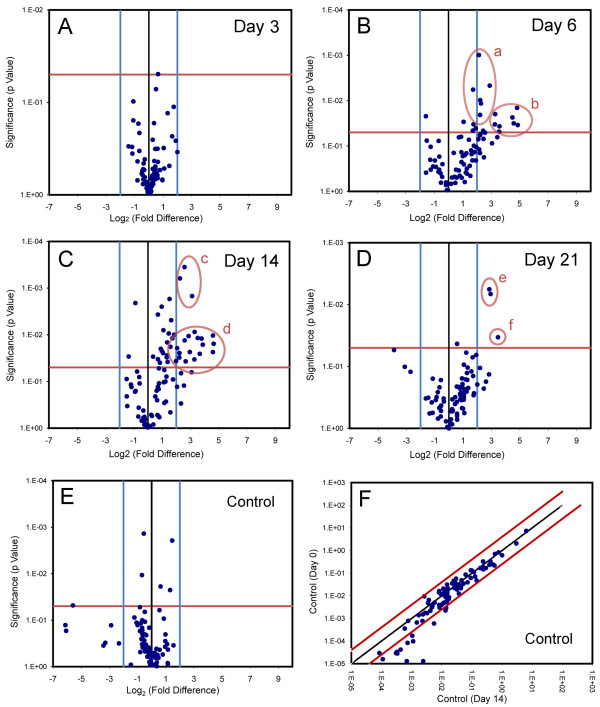
Expression of angiogenesis-related genes in CD31+ cells after pneumonectomy. A-D) Gene expression in mice 3, 6, 14 and 21 days after pneumonectomy was compared to age-matched controls without surgery. The log2 fold-change in gene expression was plotted against the p-value (t-test) to produce a "volcano plot." The vertical threshold reflected the relative statistical significance (red horizontal line, -log10, p < 0.05); the horizontal threshold reflected the relative fold-change in gene expression (blue vertical line, 4-fold). The significantly up-regulated expression of specific genes (red elipses): a) Tnfaip2, Plg, Anpep, Pgf, Vegfb and Thbs2; b) Csf3, Col4a3, Sphk1, Ereg, Vegfa, Lect1, Col18a1 and Il6; c) Ereg, Ephb4 and Vegfa; d) Tbx1, Cxcl5, Col4a3, Col18a1, F2, Vegfc, Sphk1, Ccl11, S1pr1, F2, Il6, Lect1, Flt1 and Csf3. e) Sphk1 and Vegfa; f) Csf3. Each data point reflects triplicate or quadruplicate arrays of 9 to 21 mice (Day 0, N = 15 mice; Day 3, N = 9 mice; Day 6 = 9 mice; Day 14, N = 9 mice; Day 21, N = 21 mice). E) Indicating a limited impact of the thoracotomy alone, the volcano plot comparison of sham thoracotomy and no surgery control demonstrated no significant change in gene expression on Day 14 after pneumonectomy. F) Scattergram indicating the stability of the control cell population (CD11b- CD31- ) used for gene expression analysis. Angiogenesis gene expression in the CD11b-CD31- cells was compared on Day 0 and Day 14 after pneumonectomy (N = 3 mice, each time point). Gene expression demonstrated only one gene (Bai1) with significantly decreased expression on Day 14 after pneumonectomy.